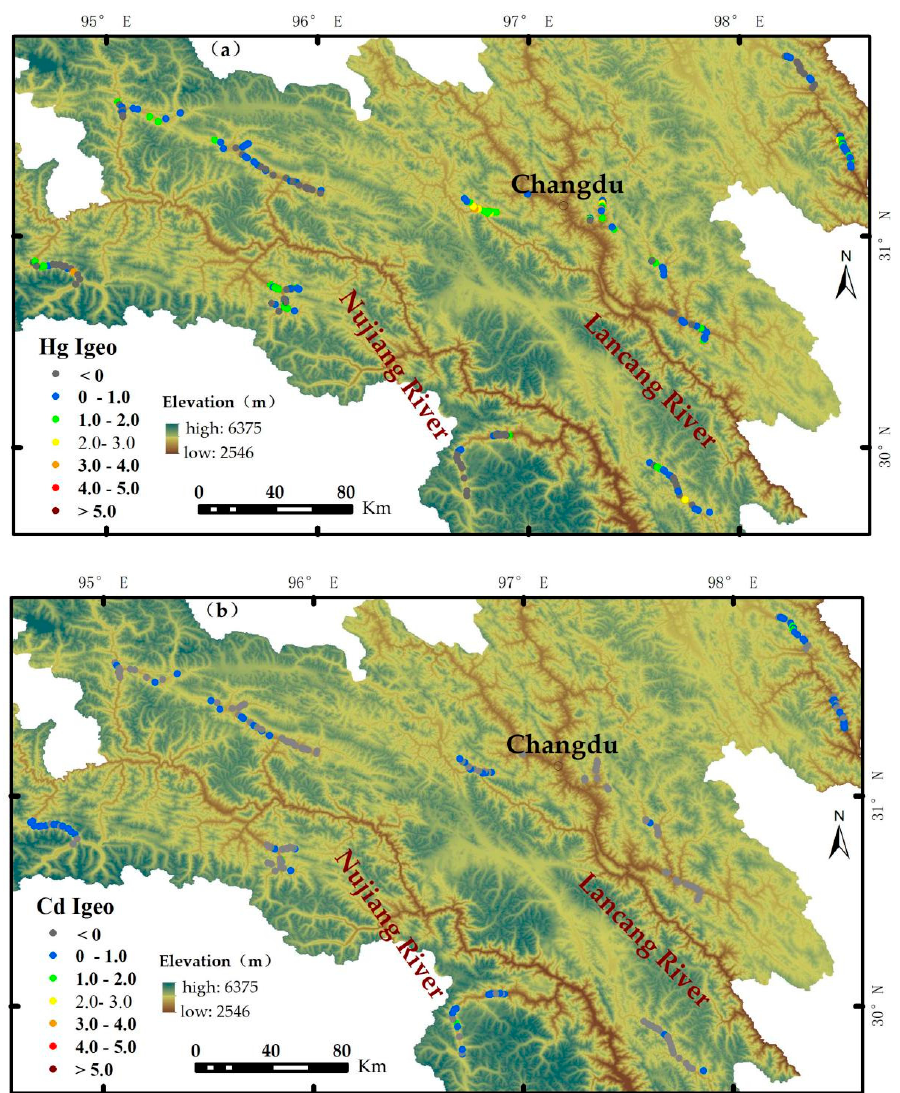
Figure 3. Spatial distribution of geoaccumulation of Hg ( a ) and Cd ( b ).